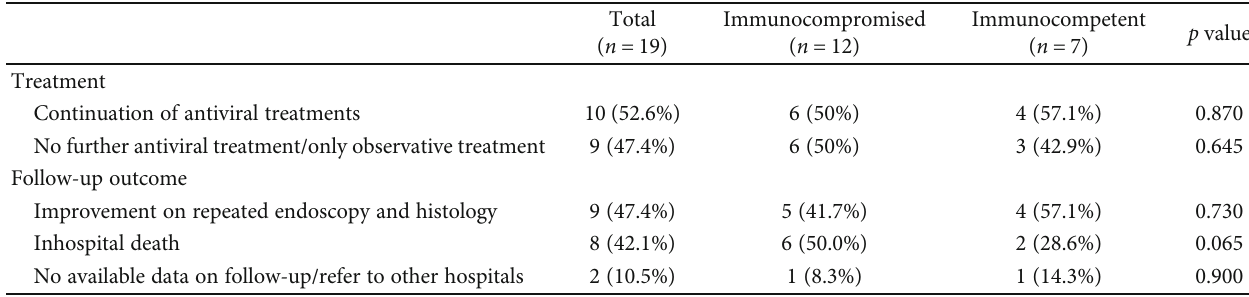
Table 4: Treatment and outcome of CMV-detected patients on the tissue at the follow-up